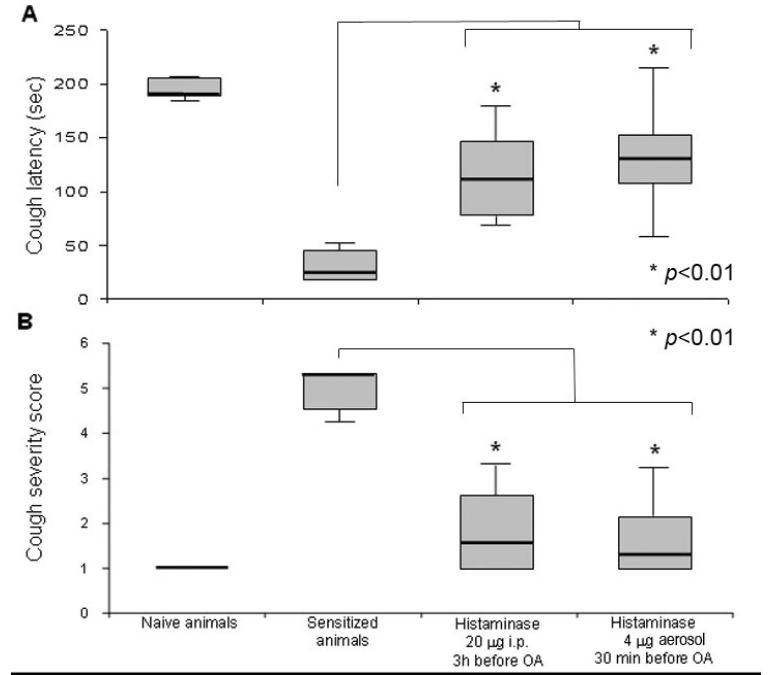
FIGURE 3. Effects of CNB 2 -Sepharose 6MB immobilized histaminase (20 μ g, given intraperitoneally 3 h before OA, or 4 μ g/ml, given by aerosol 30 min before OA) on cough latency (A) and cough severity score (B) induced by OA challenge in sensitized guinea pigs. Data are expressed as box plot of 12 experiments; block lines represent median values, boxes represent interquartile range, whiskers represent extreme